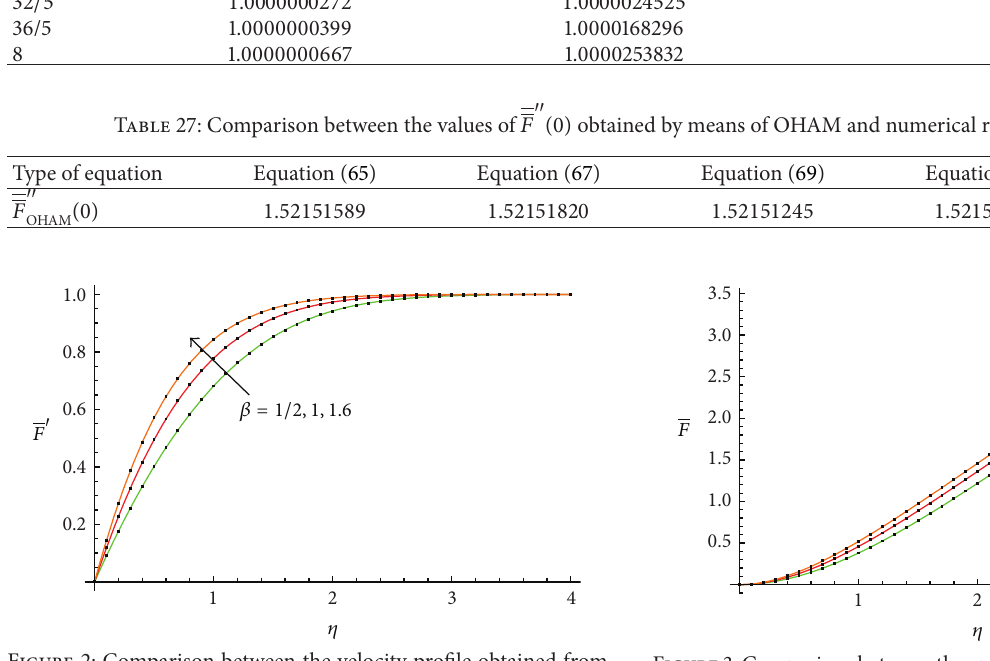
Figure 3: Comparison between the approximate solutions (51), (59), and (67) and numerical results with the auxiliary function equation (37) in the cases 𝛽 = 1/2 , 1, and 1.6, respectively: —numerical; ... OHAM